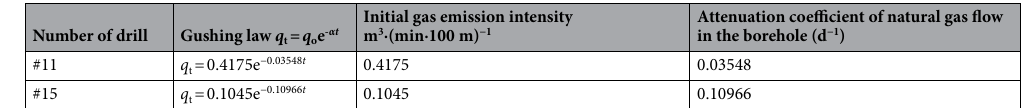
Number of drill